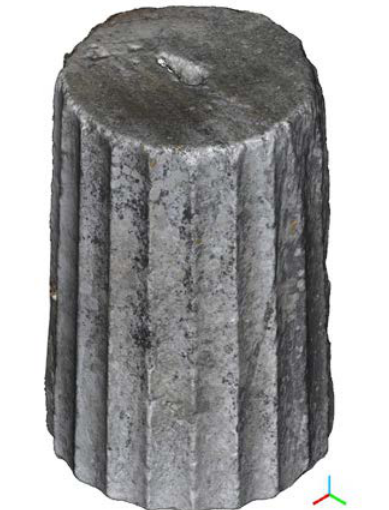
Figure 2.Doric column drum, found on the north slope of Acropolis. Point cloud produced with Agisoft PhotoScan ®